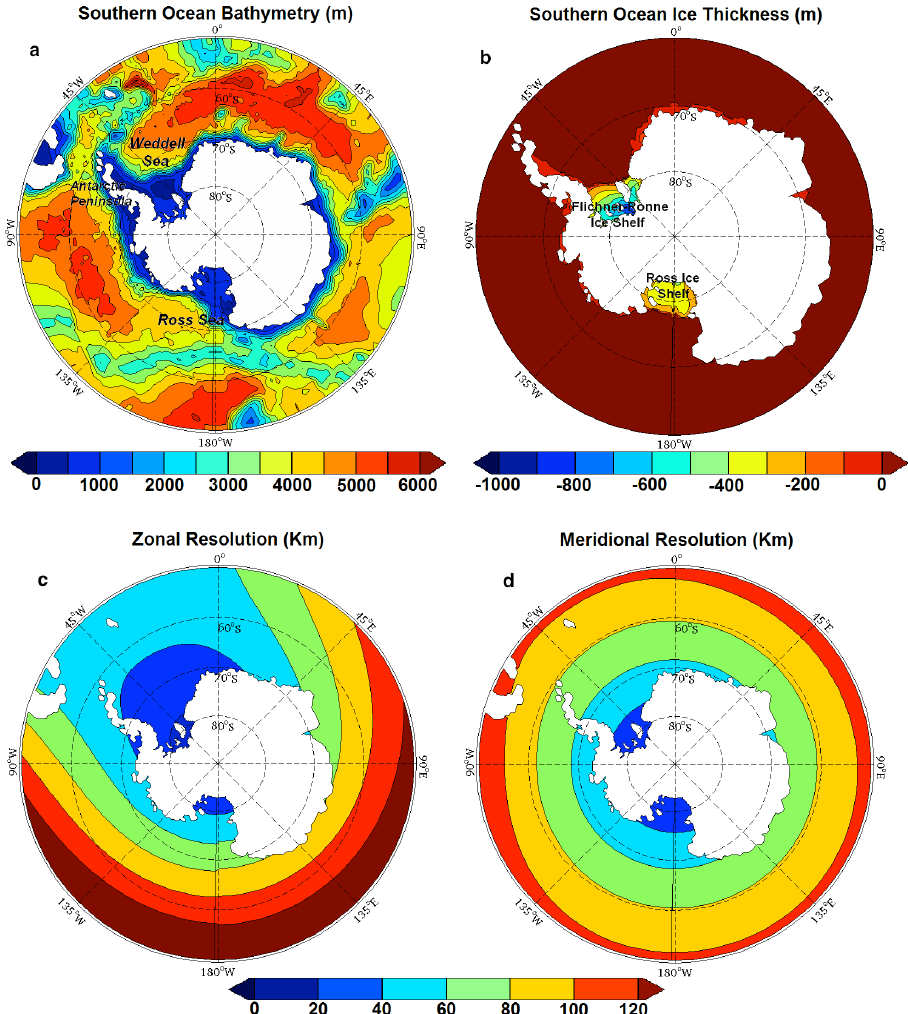
Fig. 1. Bathymetry and ice thickness in meters (a and b) and variable horizontal resolution in kilometers (c and d).